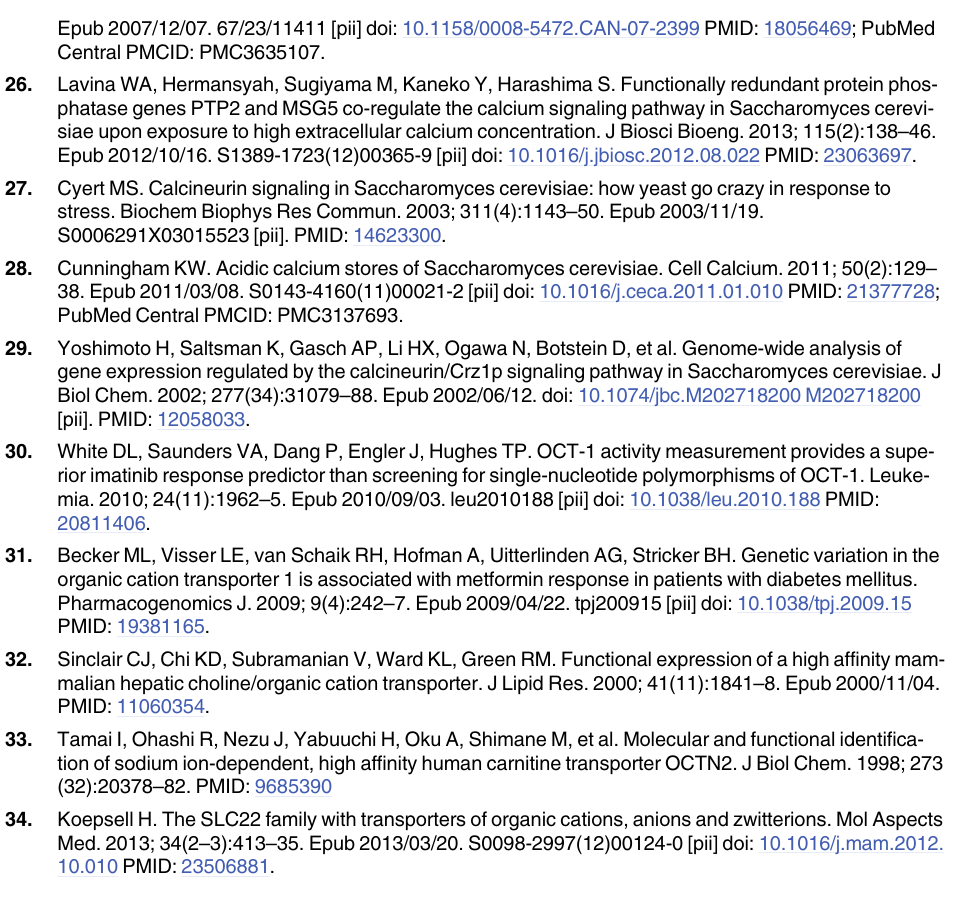
PLOS ONE | DOI:10.1371/journal.pone.0133182 July 15,